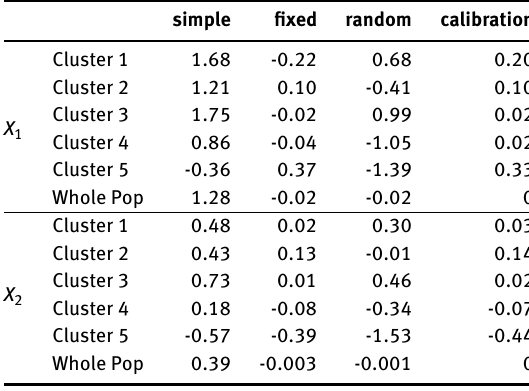
Table 3: Balance Check.